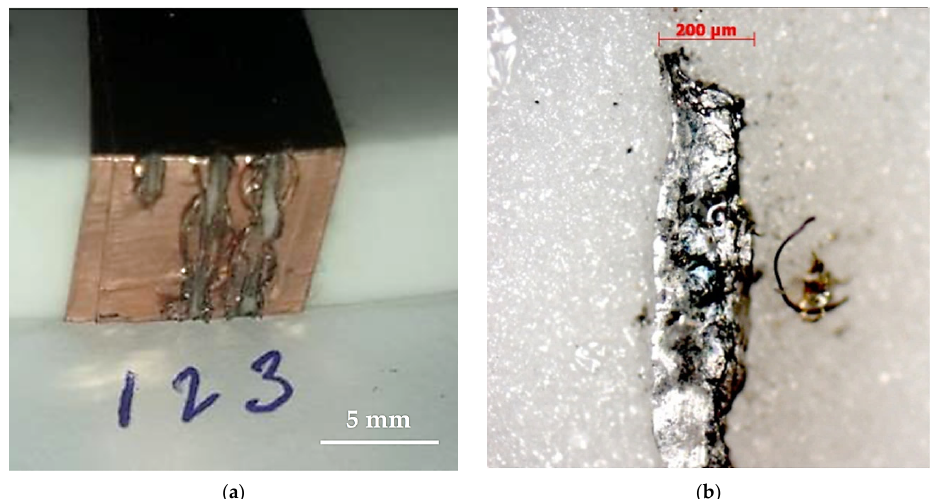
Figure 5. The preliminary testing results of the electrical discharge machining of samples coated with self-adhesive copper tape: ( a ) a sample after preliminary testing; ( b ) optical microscopy of the formed texture, 10×.